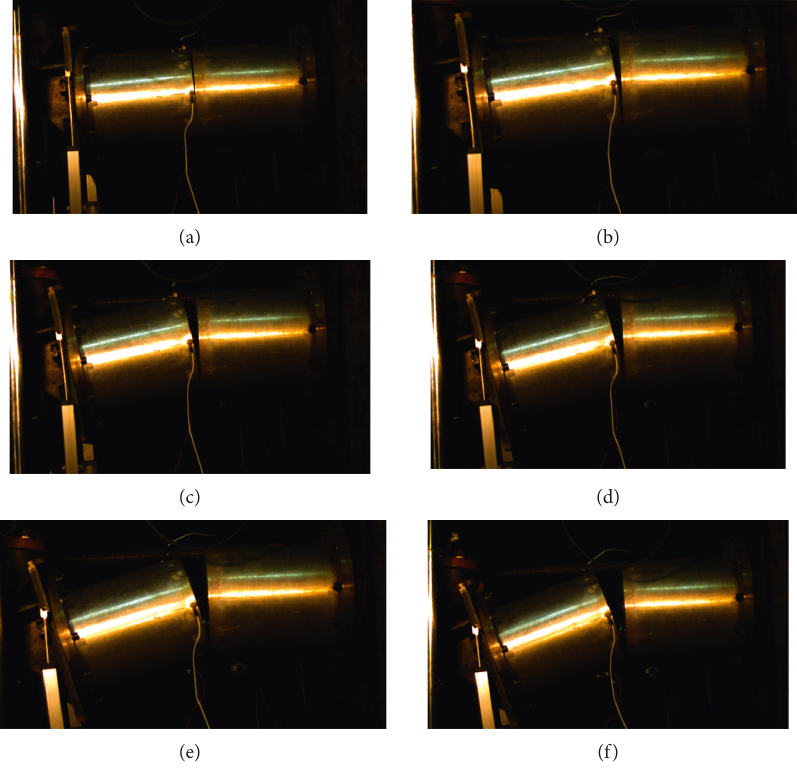
Figure 8: The failure process in the experiments. (a) 0 ms, (b) 5ms, (c) 10ms, (d) 15 ms, (e) 20ms, and (f) 25 ms.